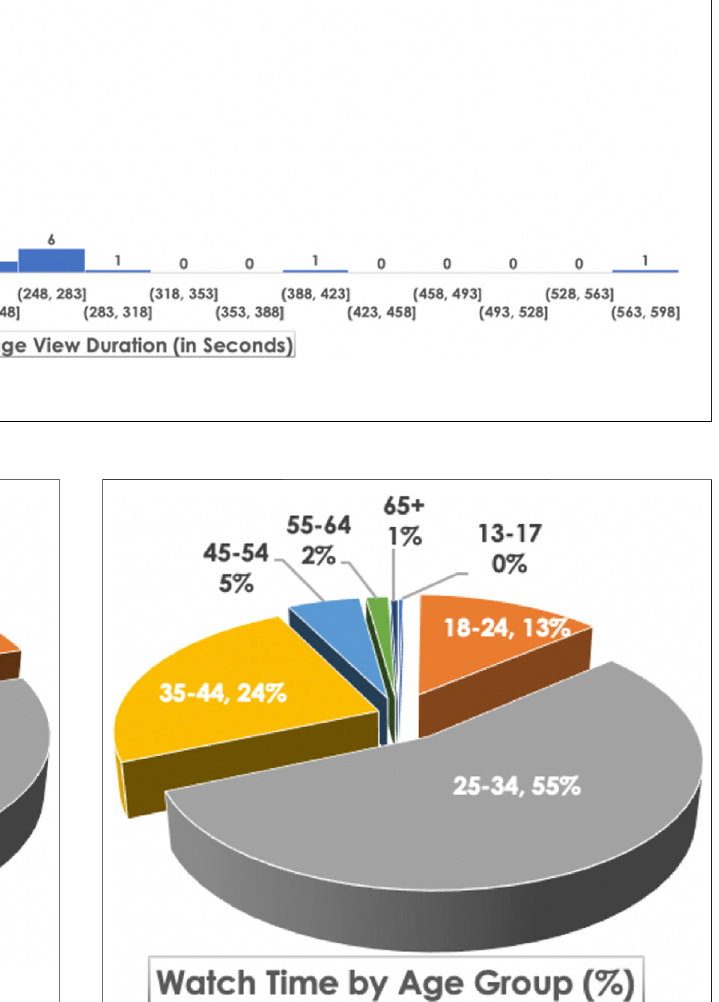
FIGURE 6 | Hand surgery international YouTube channel views by age.